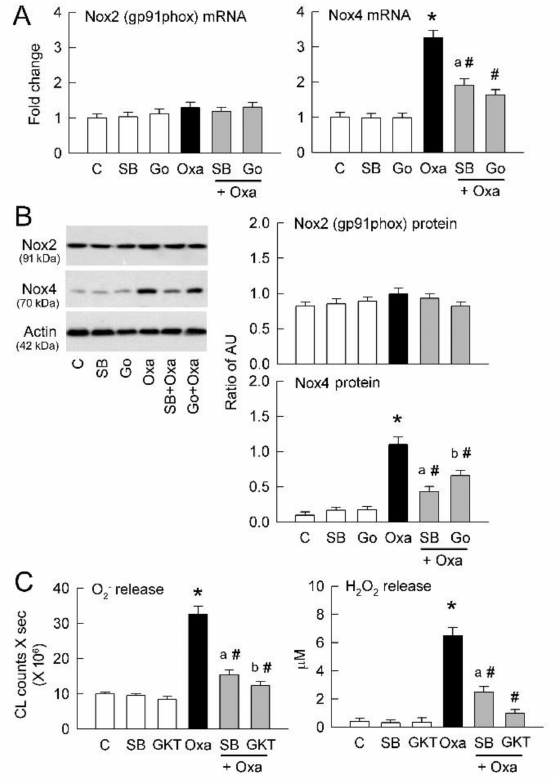
Figure 3. Blockade of TRPV1 and PKC on oxalate-mediated Nox expression and reactive oxygen species (ROS) generation in tubular cells. ( A ) mRNA levels of Nox2 (as gp91phox) and Nox4 were examined by real-time quantitative PCR and expressed as fold change of control (C) cells (n = 6